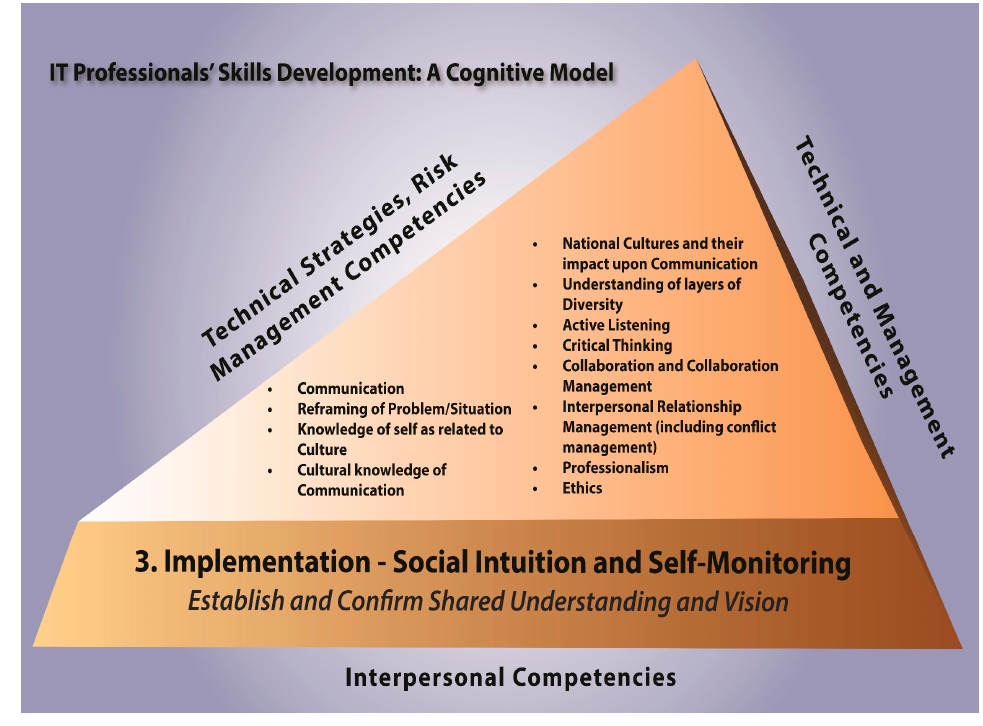
Figure 4. Illustration of the Necessary Non-technical Skills for Step 3: Implementation—Social intuition and self-monitoring Social Intuition and Contextual Awareness within a simulated IT Project Systems Development Life Cycle Context.